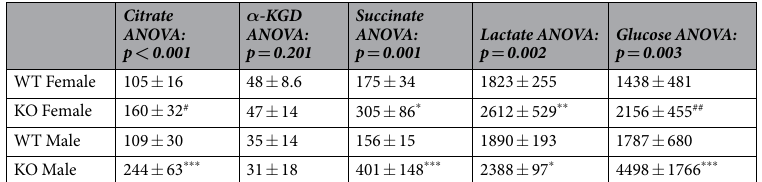
Table 1. Comparison of metabolite concentrations (glucose metabolism including Krebs cycle and glycolysis) as measured in the kidneys from female and male Ppif − / − (KO) and wild-type (WT) mice. Data is presented as average ± SD (n = 5–6; in µ M/ mg protein). One-way ANOVA significances are presented below. Tukey post hoc significance levels are as follows: * p < 0.05, ** p < 0.01, *** p < 0.001 for WT versus Ppif − / − animals (male and female), and # p < 0.05 and ## p < 0.01 for male versus female ( Ppif − / − and WT, respectively). Abbreviations: α -KGD: α -ketoglutarate.